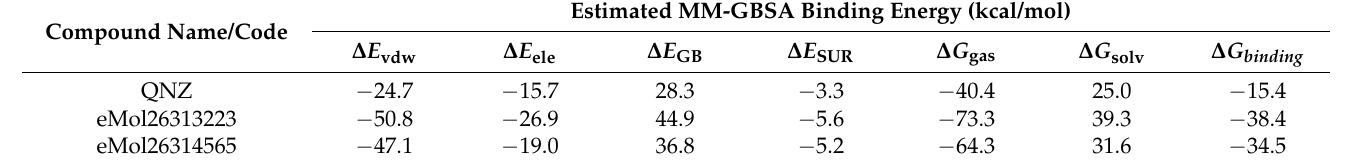
Table 3. Components of the MM-GBSA binding energies for eMol26313223, eMol26314565, and QNZ complexed with mutated PBP2a allosteric site in acidic medium throughout the MD course of 50 ns.